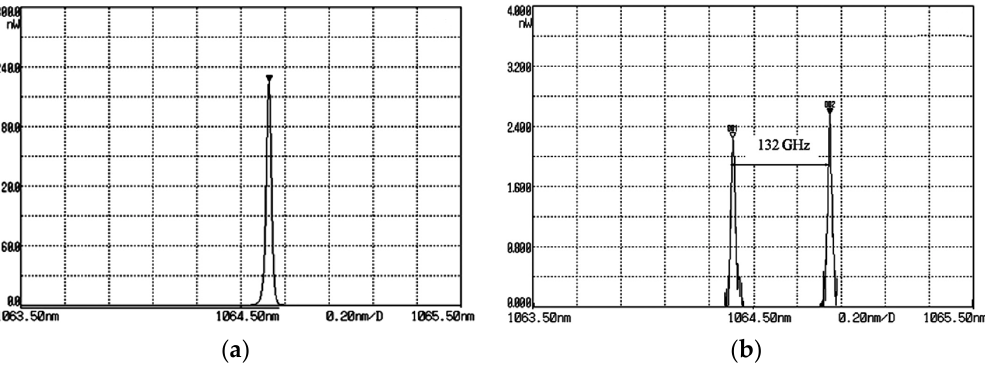
Figure 32. Oscillating spectrum of dual-frequency laser with different frequency differences of ( a ) 0 GHz and ( b ) 132 GHz [37].